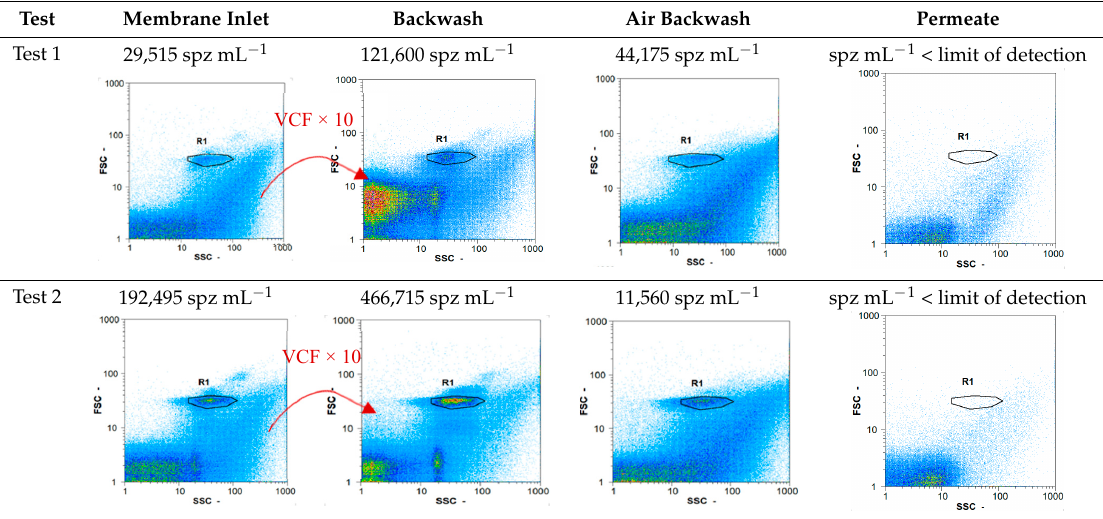
Table 9. Flow cytometry of oocytes—(J = 60 L h − 1 m − 2 and t filtration = 60 min for accidental pollution) for 2 feed concentrations. Test Membrane Inlet Backwash Air Backwash